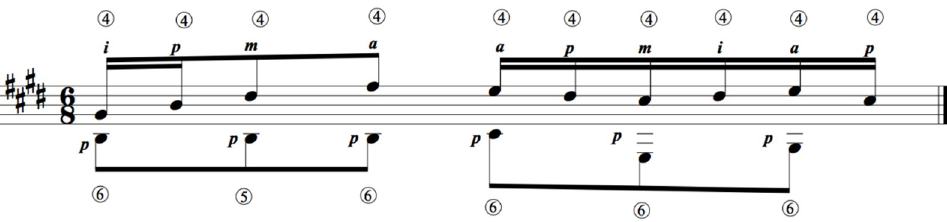
Figure 4. Physically Impossible. J. Open Innov. Technol. Mark. Complex. 2018 , 4 , x FOR PEER REVIEW